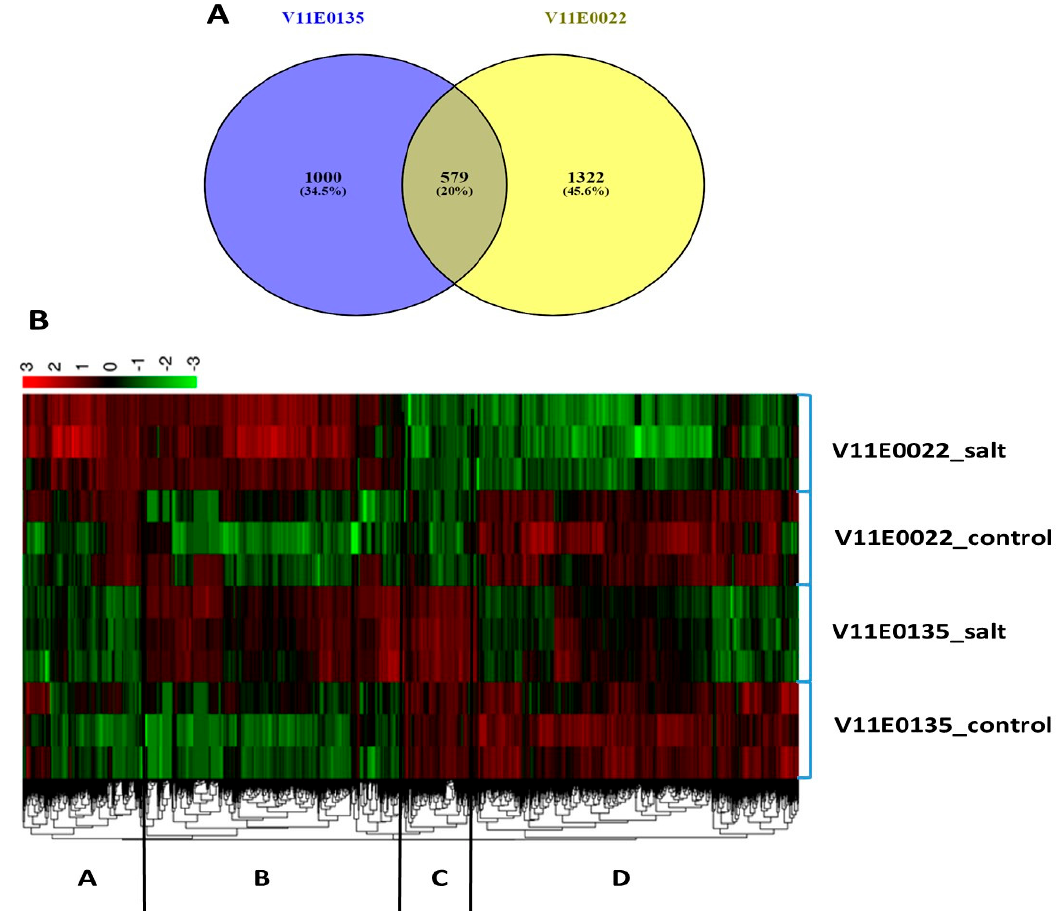
Figure 6. Distribution of differentially expressed genes (DEGs) in the leaves of both cultivars of the water dropwort under salt treatment. ( A ) Comparison of all DEGs ( B ) Cluster analysis of DEG profiles, data were divided into 4 data sets; V11E0135 control, V11E0135 salt treated, V11E0022 control, V11E0022 salt treated.